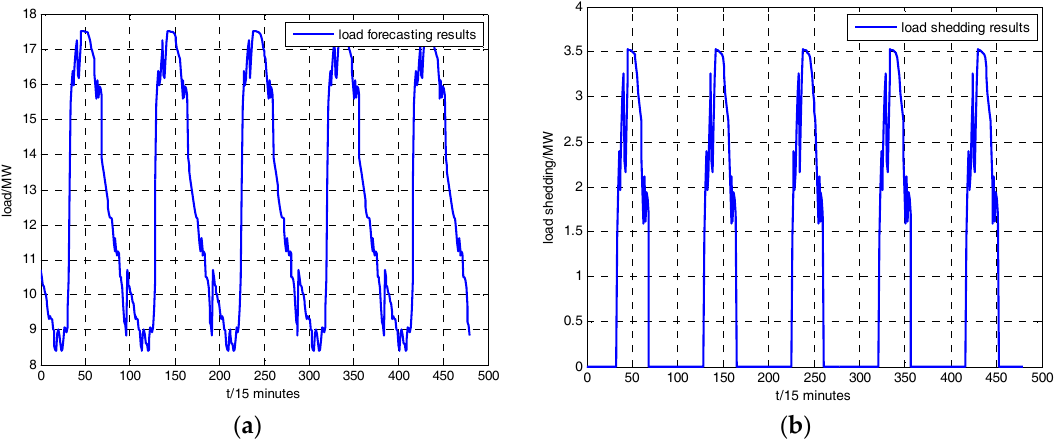
Figure 4. Simulation results of bus 17 at 24:00 ( a ) Load forecasting results of bus 17; ( b ) Load shedding results of bus 17.